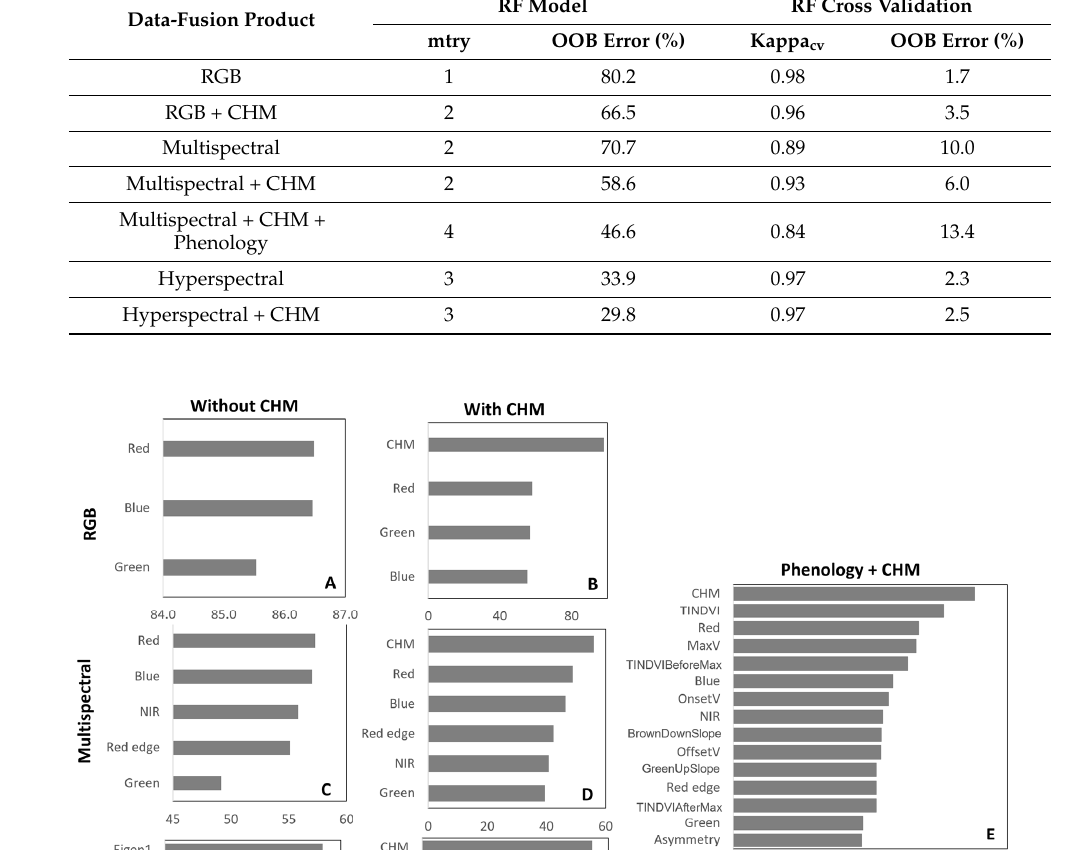
Figure 5. Variable importance plots for each sensor product (x: bands ranked by im- portance, y: variable importance values): ( A ) RGB, ( B ) RGB + CHM, ( C ) Multispectral, ( D ) Multispectral+ CHM, ( E ) Multispectral + CHM + Phenology, ( F ) Hyperspectral, and ( G ) Hy- perspectral +